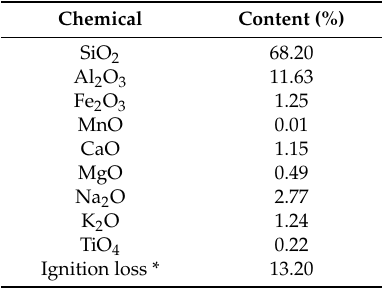
Table 1. Mineral composition of natural zeolite of mordenite